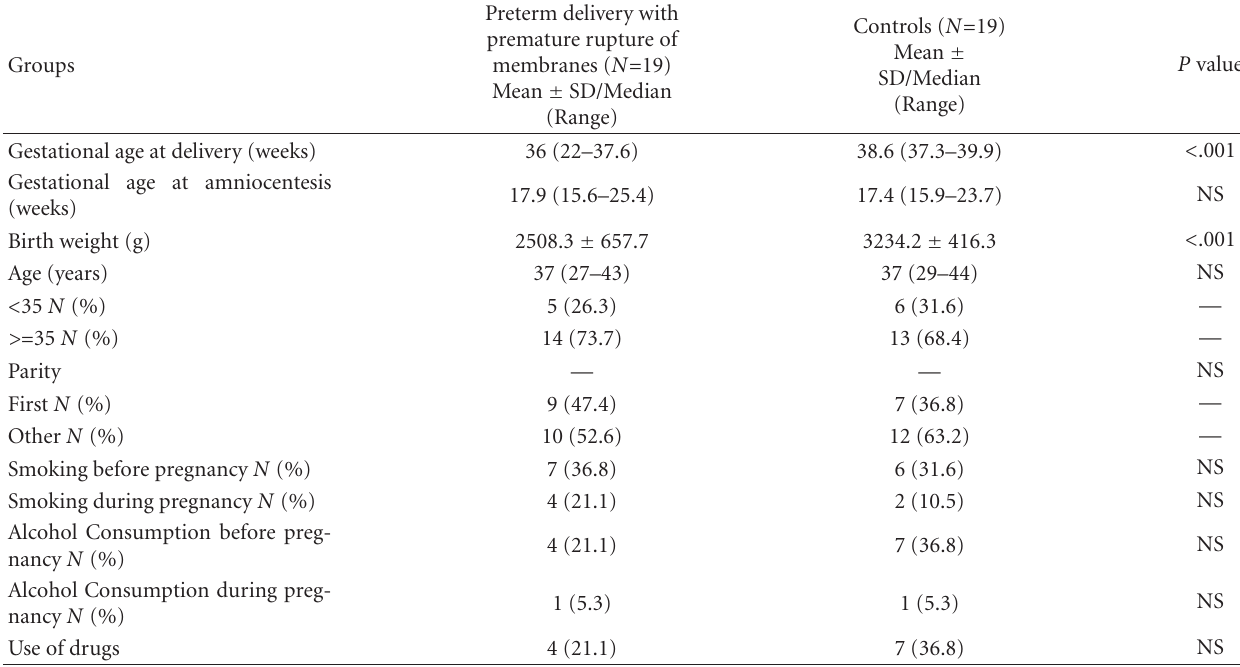
Table 2: Demographic data of women with preterm labor and premature rupture of membranes ( N = 19) and women delivering at term ( N =